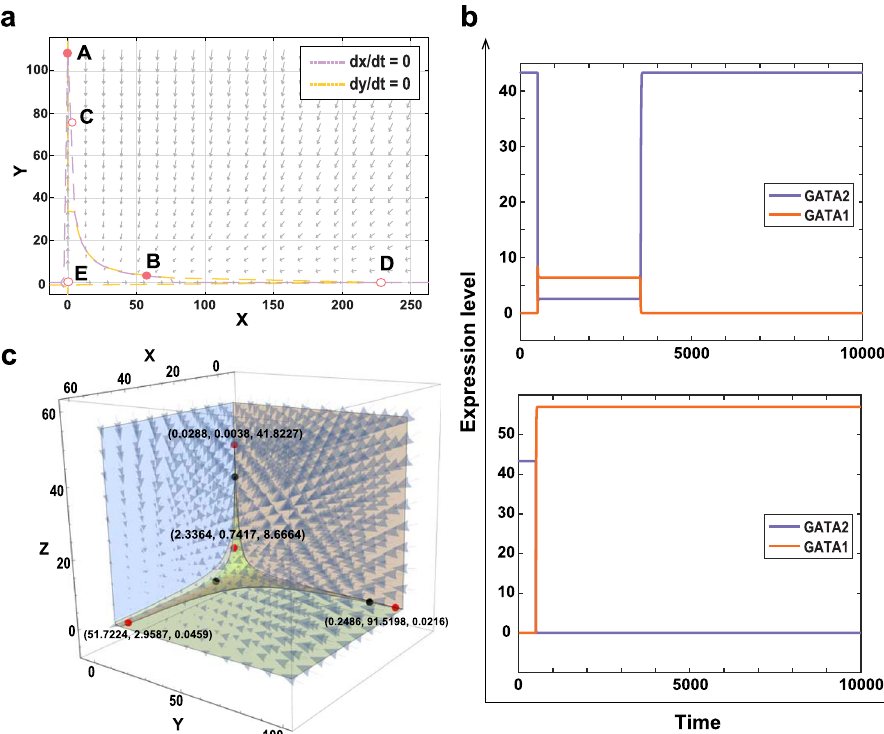
due to the displacement of GATA2 not being 0